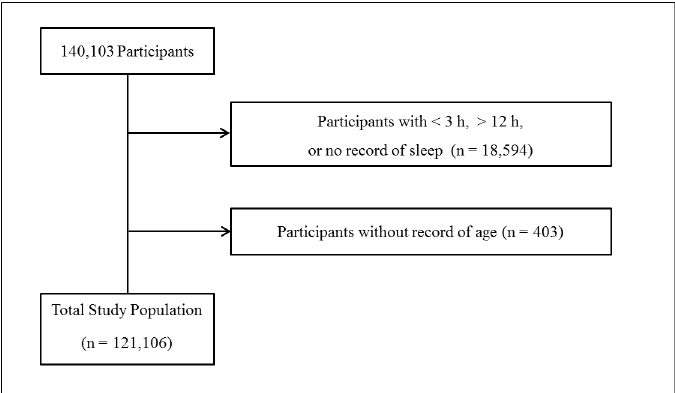
Fig 1. A schematic illustration of participant selection in the present